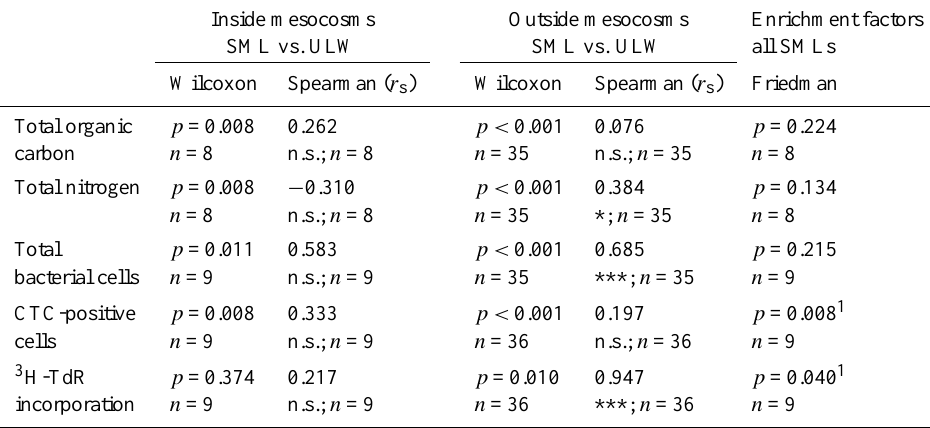
Table 2. Comparison between samples from the sea-surface microlayer (SML) inside and outside the mesocosms with respect to the underlying water (ULW). For each parameter, potential differences in absolute values between the SML and ULW (Wilcoxon test) were tested, as were potential correlations between these values (Spearman-rho correlation coefficient). Moreover, the enrichment factors among all SML-samples inside and outside the mesocosms were examined for significant differences (Friedman test).